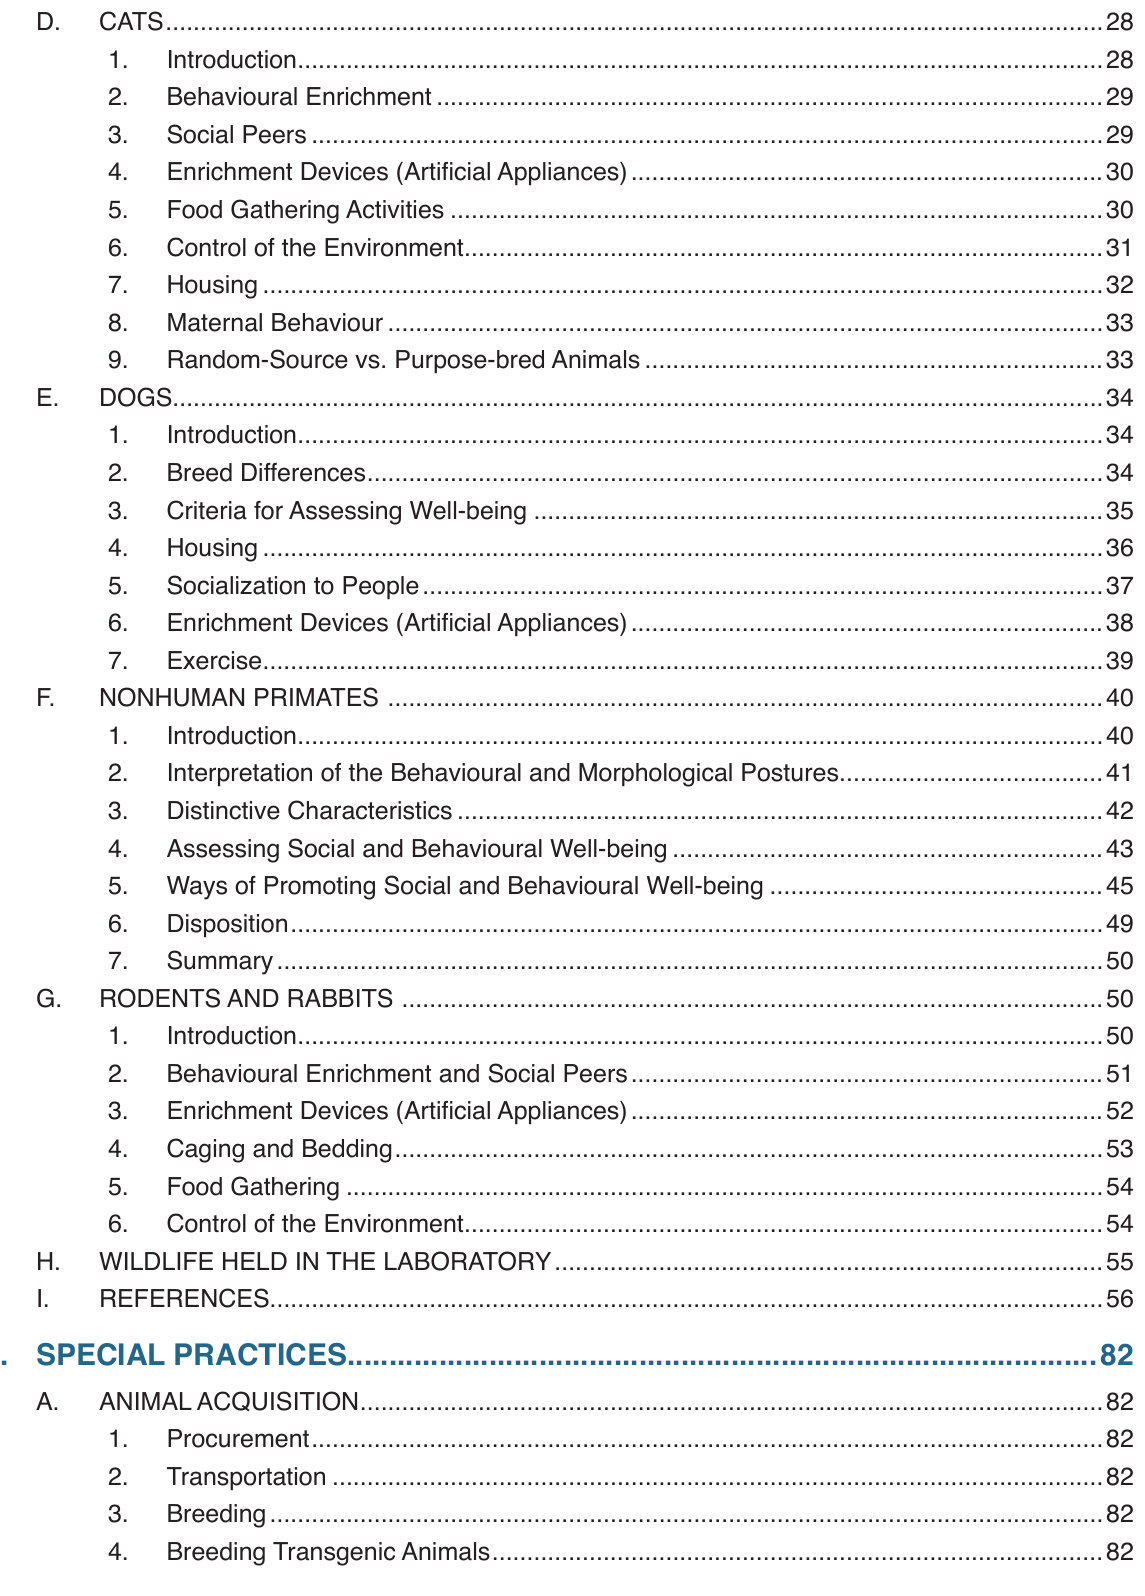
Guide to the Care and Use of Experimental Animals, Volume 1, 2 nd